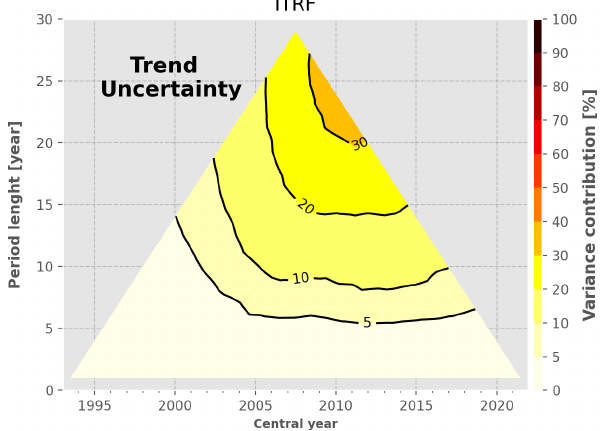
Figure A7. Variance contribution to the GMSL trend variance of the ITRF drift uncertainty.